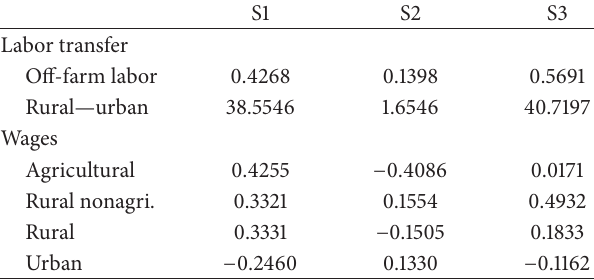
Table 1: Labor transfer and wages in 2015 (% change).